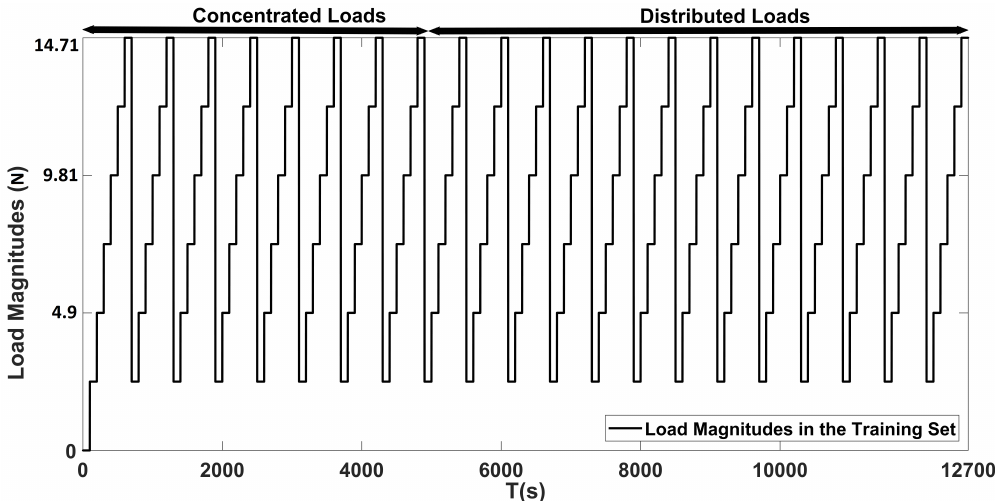
Figure 18. Load magnitudes used for training the proposed estimation